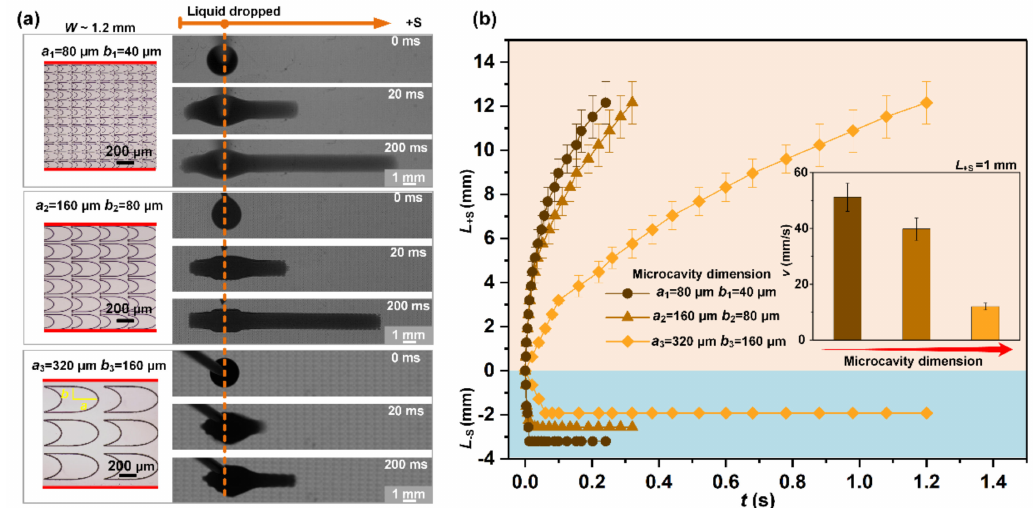
Figure 6. ( a ) Influence of the dimension of microcavity on unidirectional spreading. ( b ) Transport distance of liquid as a function of time. The inset image shows the average transport velocity of liquid on the channels with di ff erent microcavity